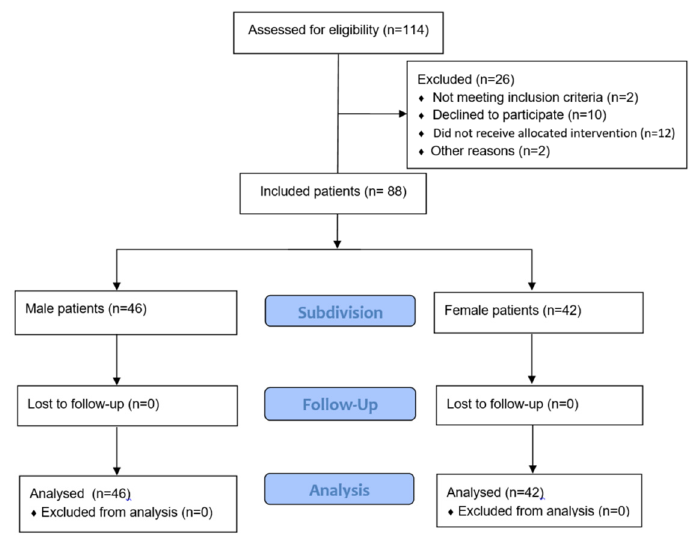
Figure 1. Flow chart of the patients included in the study.